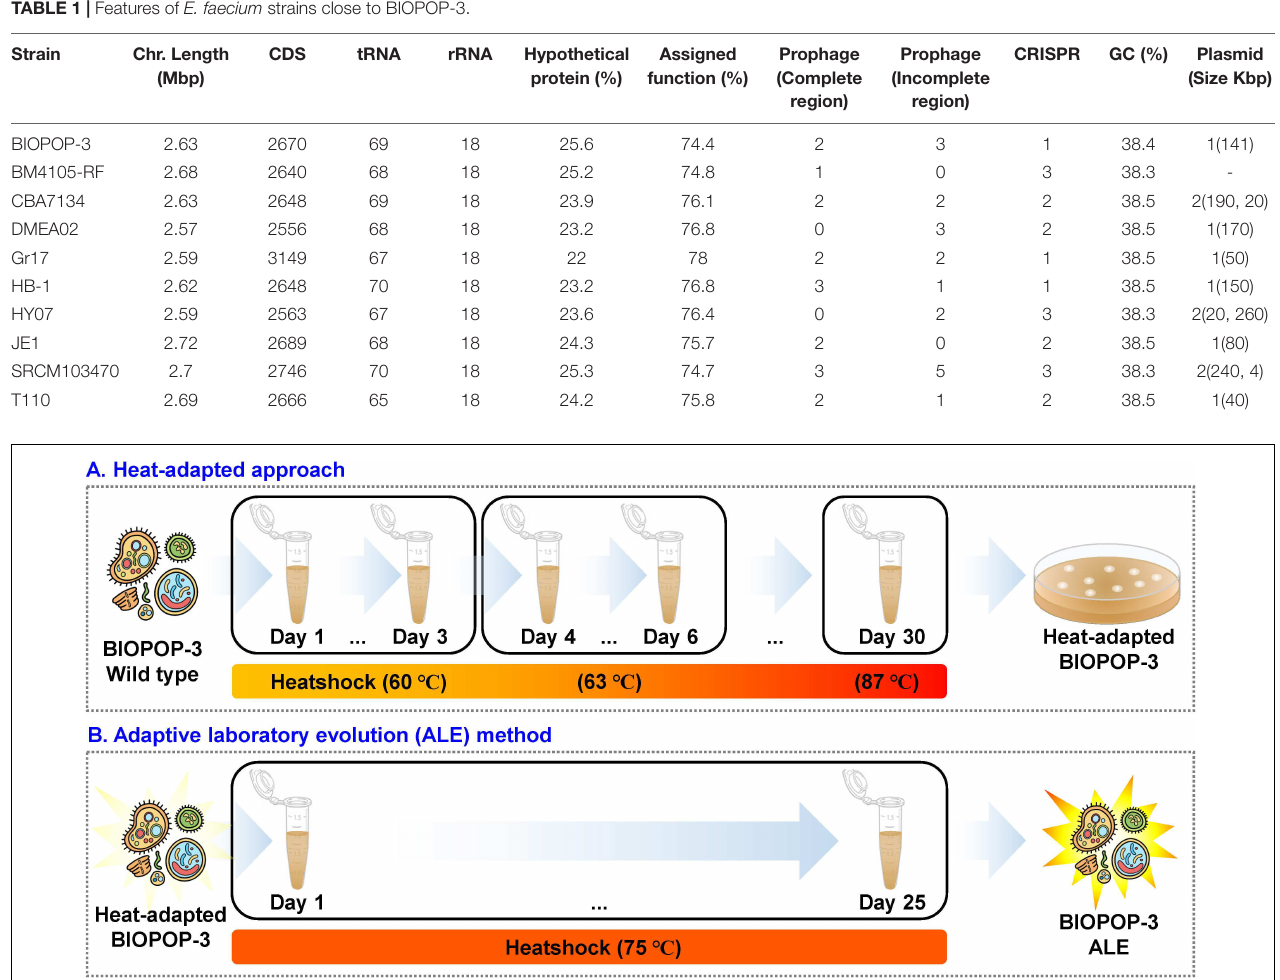
FIGURE 3 | Procedure for adaptive laboratory evolution experiment. (A) The procedure of heat-adapted experiments. (B) The temperature was constant at 75 ◦ C. The duration of heat shock was 1 min and after heat shock, cells were cooled down at room temperature followed by incubation of 24 h at 37 ◦ C.